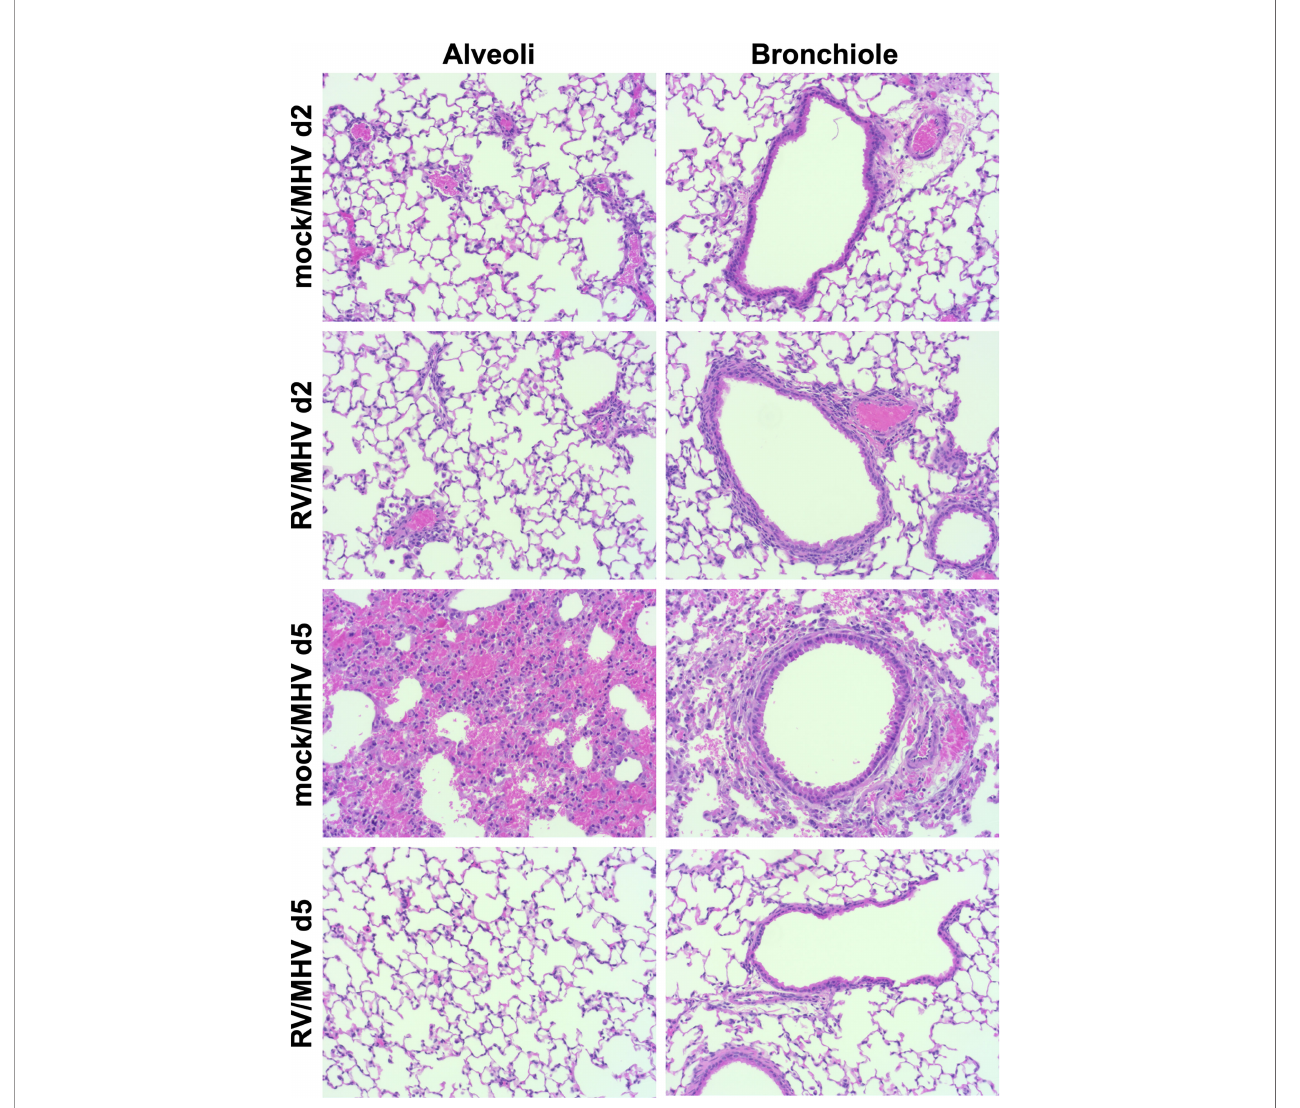
FIGURE 5 | Priming with RV limits pulmonary in fl ammation and damage upon MHV-1 infection. Mice (n=2 per group and time point) were inoculated intranasally with RV (7.6x10 6 TCID 50 ) or saline (mock) on day -2, and MHV-1 (2x10 5 PFU) on day 0. Lungs were collected on days 2 and 5, fi xed in formalin, and 5 m m sections were stained with hematoxylin and eosin. Representative images from one mouse per group are shown at 20X magni fi cation of alveoli and